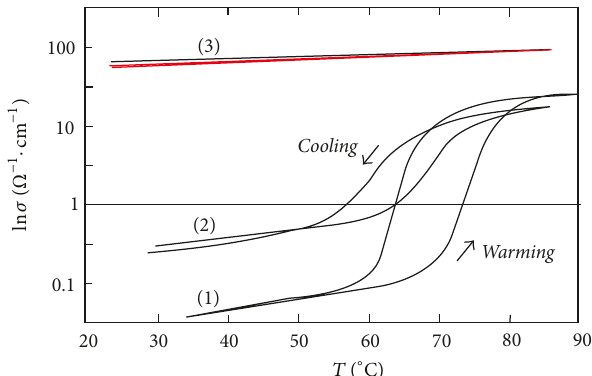
Figure 5: Conductivity temperature dependence of VO 2 film: initial sample 2 (1) , the region covered by a mask (2) , and region with implanted hydrogen (3) . The implanting dose is 7.5 ⋅ 10 16 cm −2 .